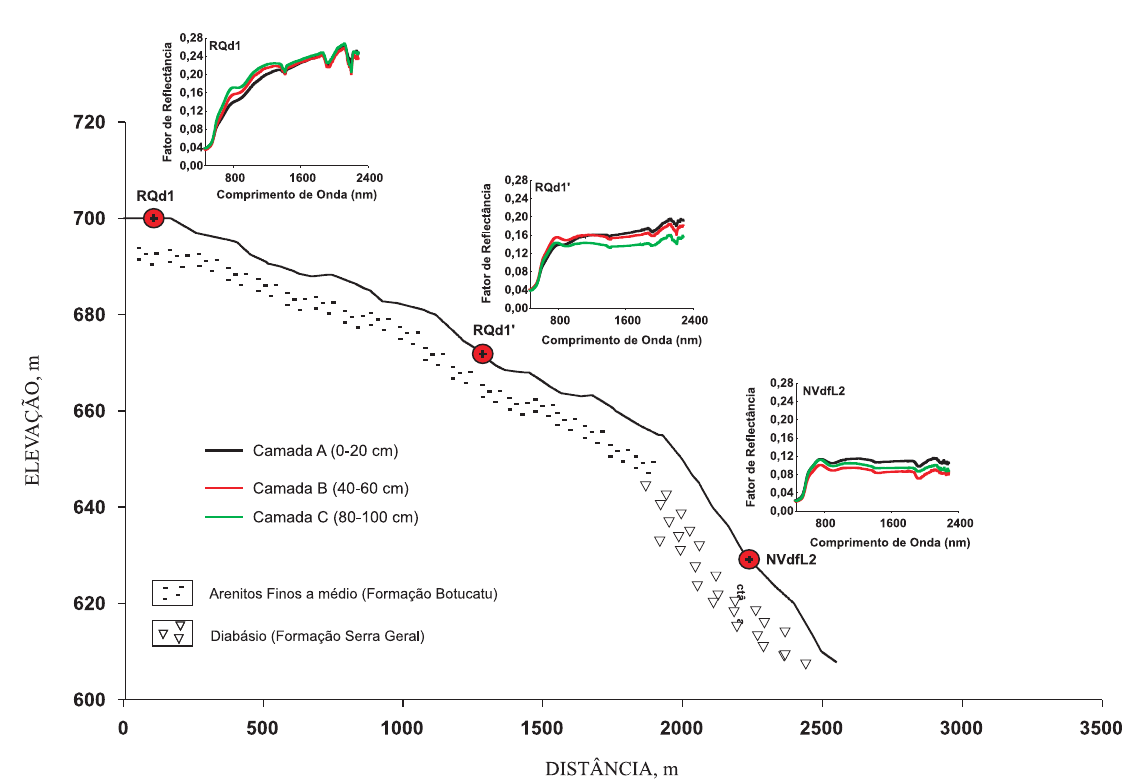
Figura 2. Variabilidade longitudinal e curvas espectrais dos solos em diferentes camadas na toposseqüência 2 da área de